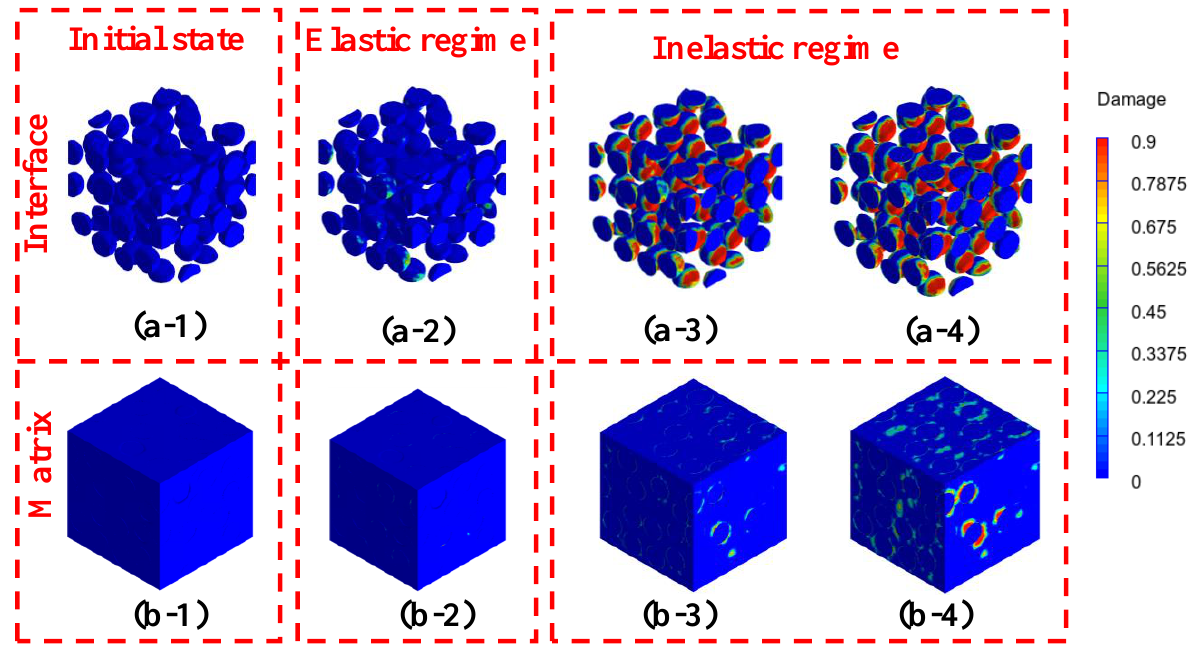
Figure 5. Progressive damage for mortar composition with 10% wollastonite fibers for a strain rate of 200/s at ( a ) interface and ( b ) matrix in fiber; the strain states correspond to ( a-1 ) and ( b-1 ) undeformed, ( a-2 ) and ( b-2 ) at 0.0018, ( a-3 ) and ( b-3 ) at 0.0033, and ( a-4 ) and ( b-4 ) at 0.0044.